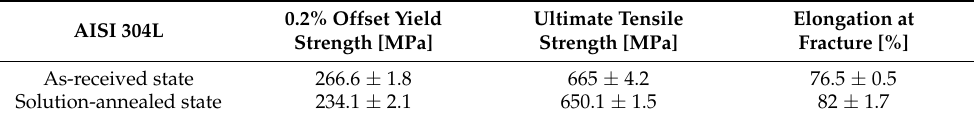
Table 2. Basic mechanical properties of both states of the experimental material AISI 304L.